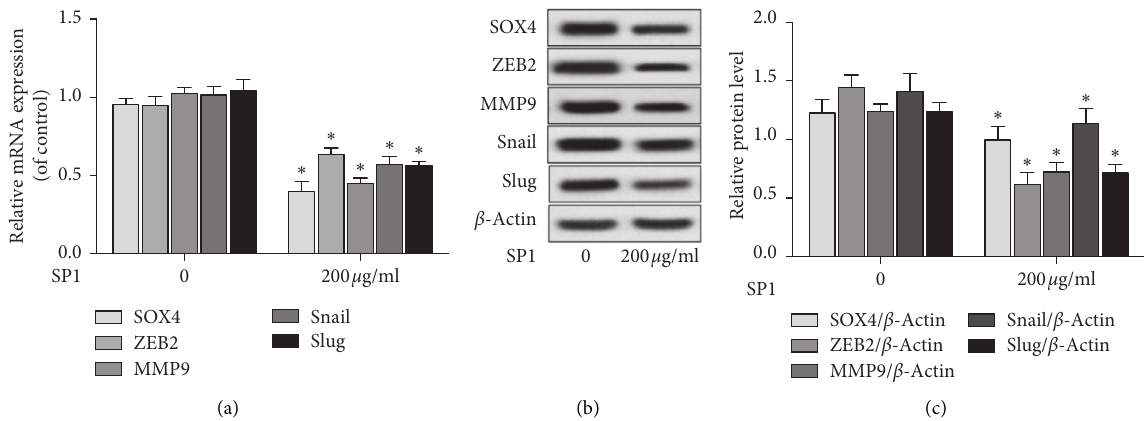
Figure 7: The expression of SOX4, ZEB2, MMP9, Snail, and Slug mRNA in MGC-803cells of the control group (SP1 0 μ g/ml) and SP1 treatment group (200 μ g/ml) for 72h was detected by qRT-PCR. (b) The protein levels of SOX4, ZEB2, MMP9, Snail, and Slug in MGC-803 cells of control group (SP1 0 μ g/ml) and SP1 treatment group (200 μ g/ml) for the 72h were detected by Western blot. Compared with the control group, ∗ P < 0 . 05.